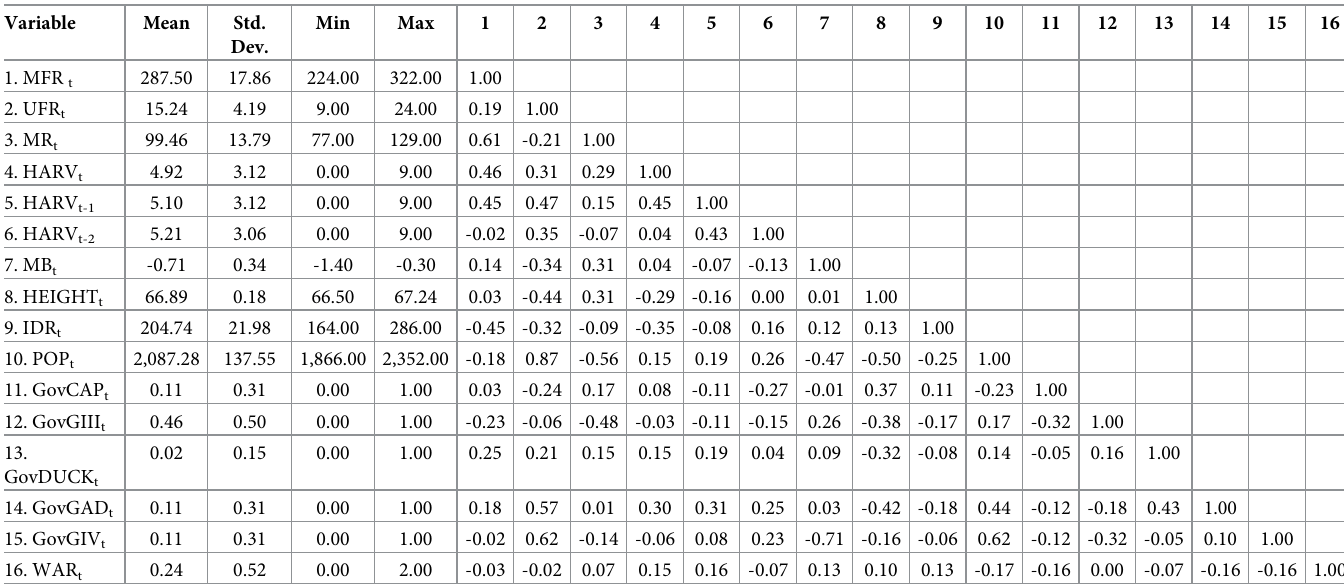
Table 2. Summary statistics and correlation coefficients.